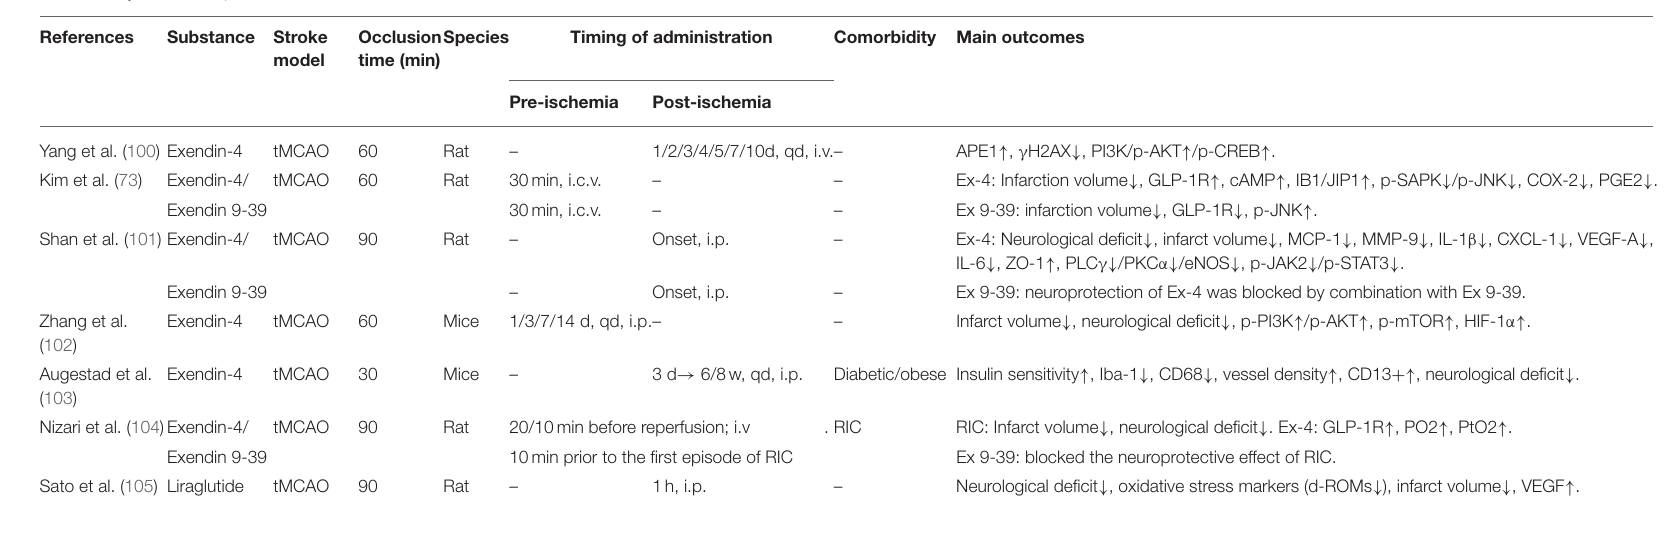
TABLE 2D | A review of preclinical studies of GLP-1 and GLP-1RAs in